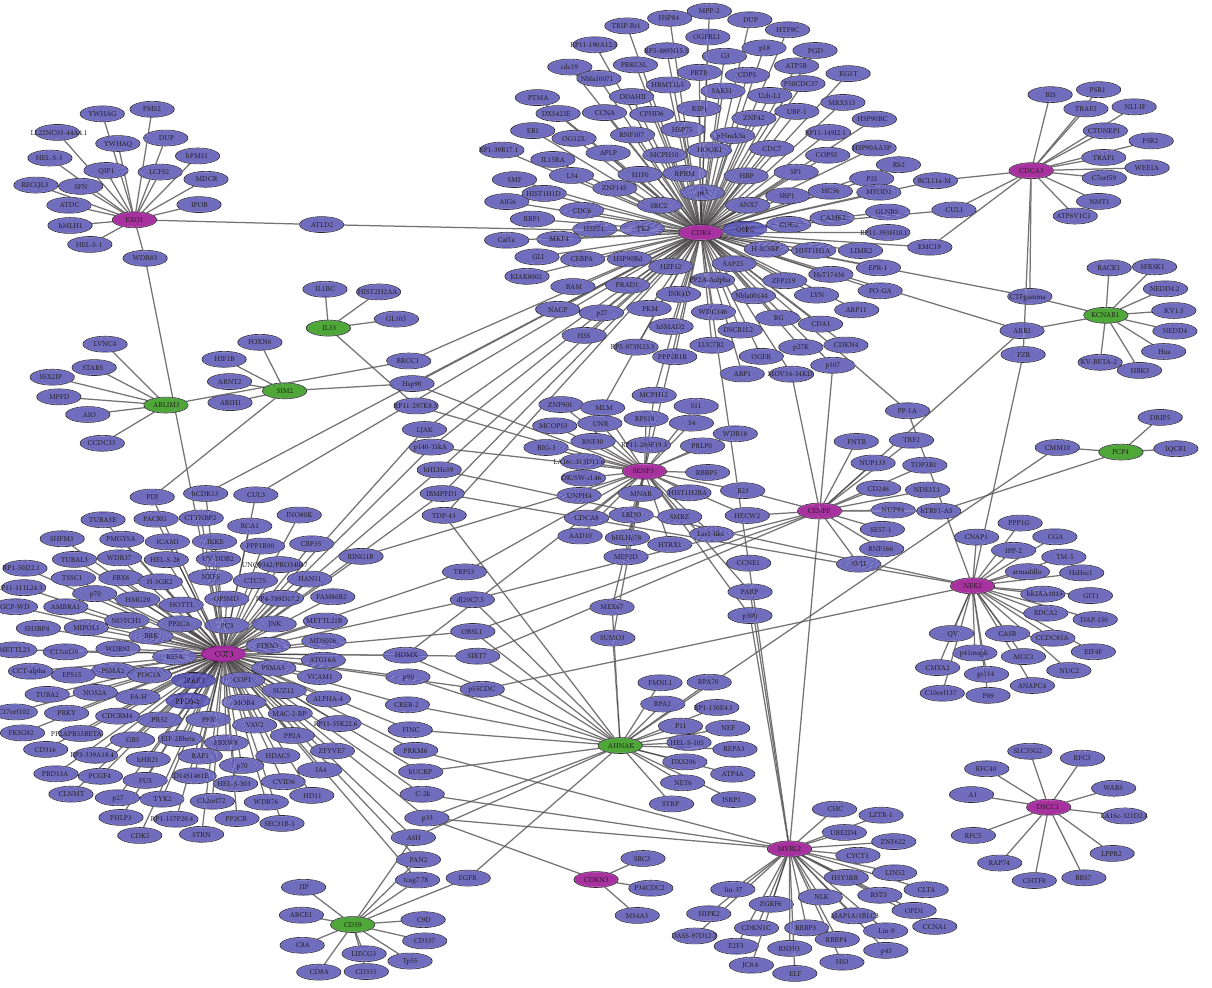
Figure 1: The protein-protein network of top 10 up- and downregulated DEGs in EC. The green circular nodes represent downregulation DEGs in EC; the red circular nodes represent downregulation DEGs in EC. Solid lines indicate interaction between DEGs and